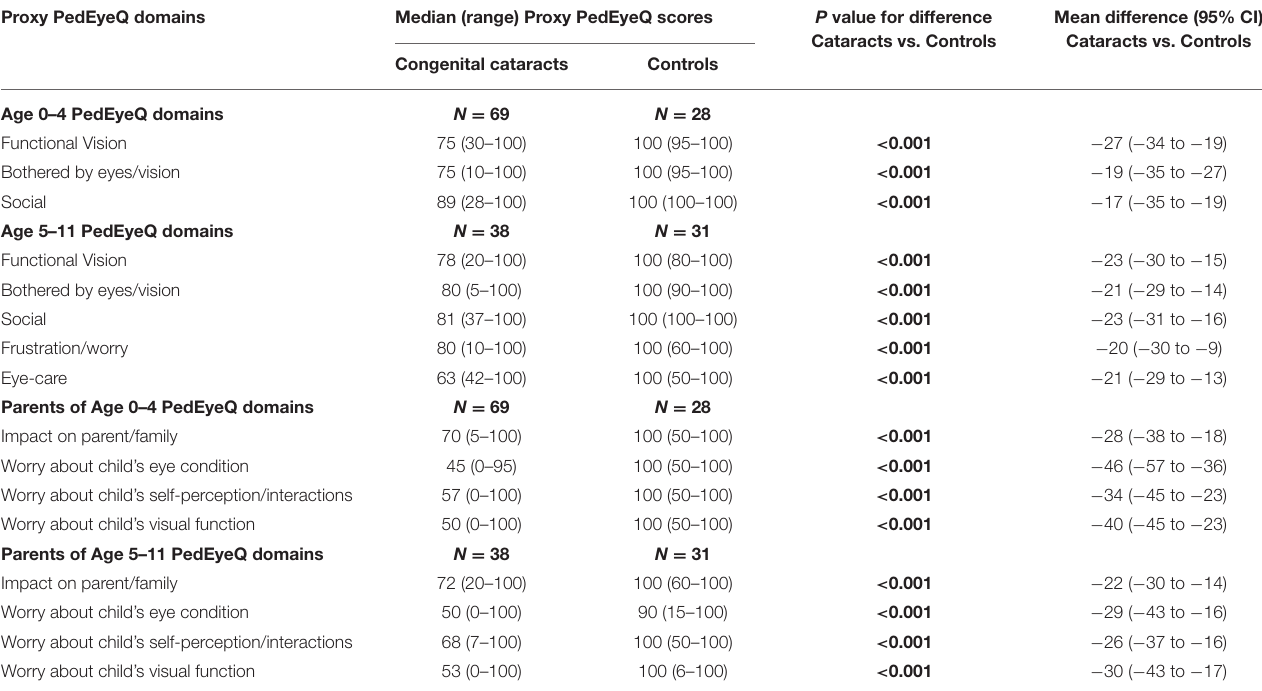
TABLE 2 | PedEyeQ domain scores for kids’ age among 0–4 with congenital cataracts ( N = 69), age among 0–4 normal controls ( N = 28), age among 5–11 with congenital cataracts ( N = 38), age among 5–11 normal controls ( N = 31). Proxy PedEyeQ domains Median (range) Proxy PedEyeQ scores P value for difference